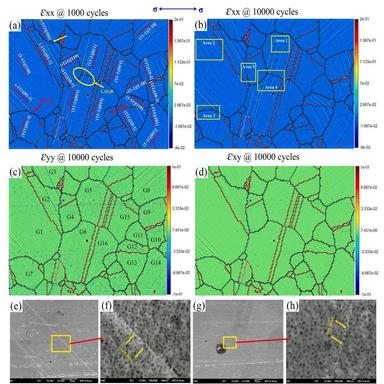
(a) ϵxx strain map at 1000 cycles; (b) ϵxx, (c) ϵyy and (d) ϵxy strain map at 10,000 cycles; (e)–(f) slip band morphology at 10,000 cycles.